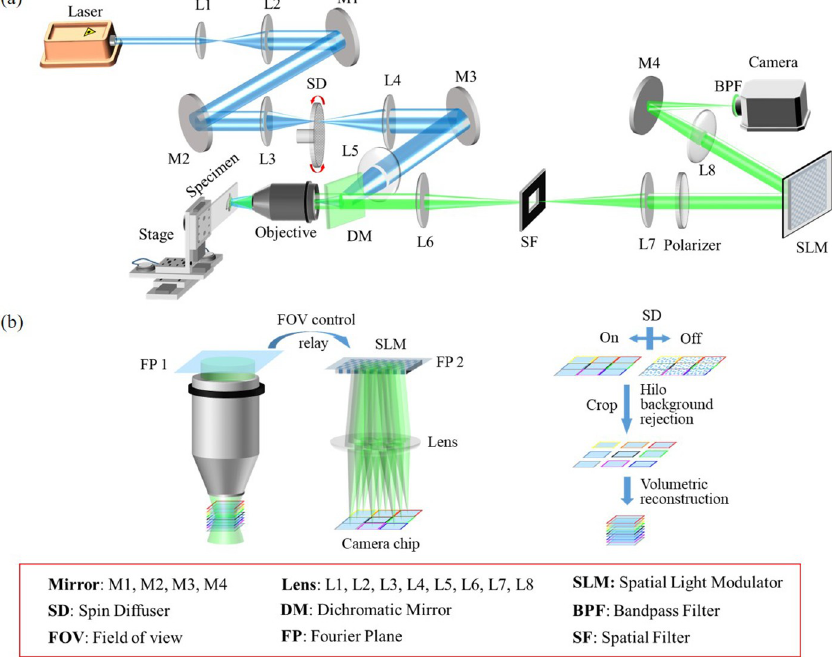
Fig 1. Experimental setup and working principle of HiLo-MFM (a) Optical configuration of the HiLo-MFM system; M1 –M4, mirrors; L1 –L8, lenses; SLM, spatial light modulator; SD, spin diffuser; DM, dichroic mirror; BPF, band pass filer; FOV, field of view; FP, Fourier plane; SF, spatial filer; (b) working principle of